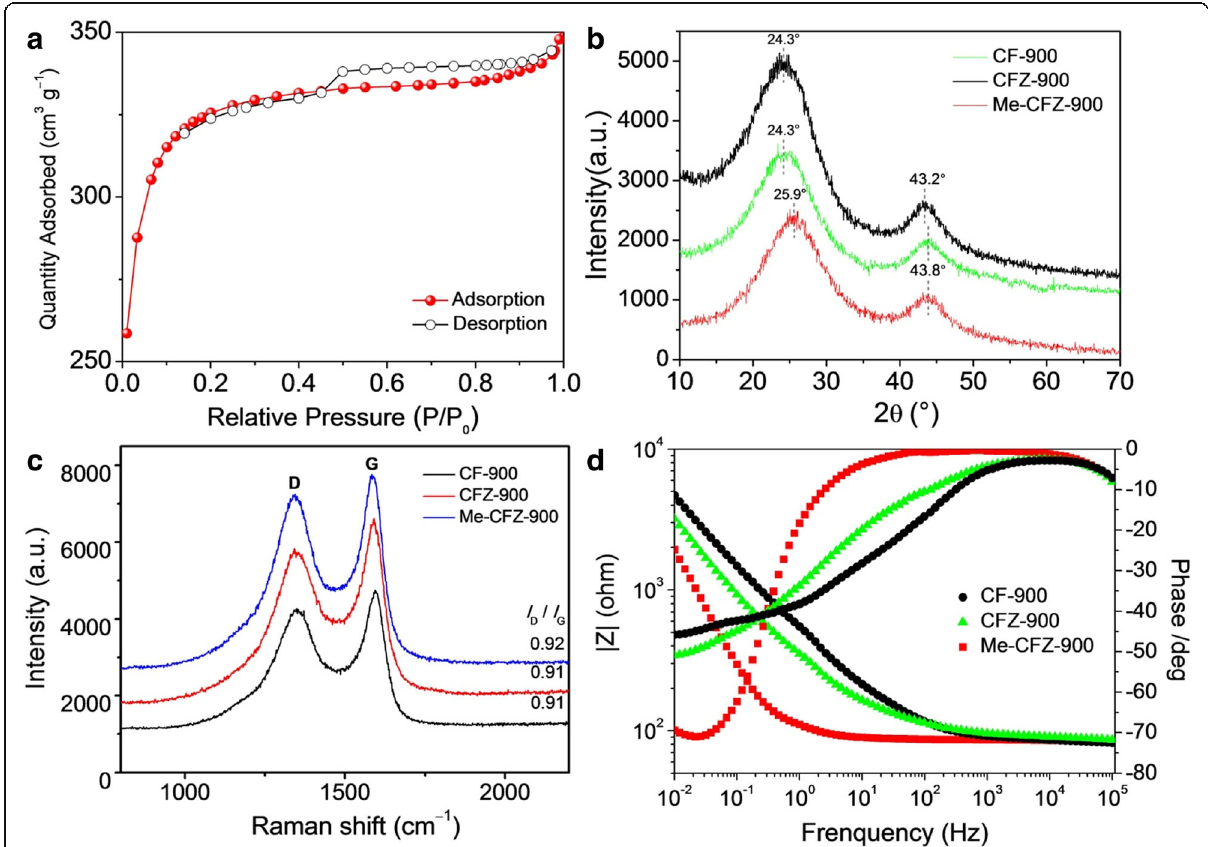
Fig. 3 a N 2 -sorption isotherms of Me-CFZ-900. b XRD patterns of CF-900, CFZ-900, and Me-CFZ-900. c Raman spectra of CF-900, CFZ-900, and Me-CFZ-900. d Bode spectra of CF-900, CFZ-900, and Me-CFZ-900 under a sine wave of 5.0 mV amplitude in the frequency range of 100 kHz to 10